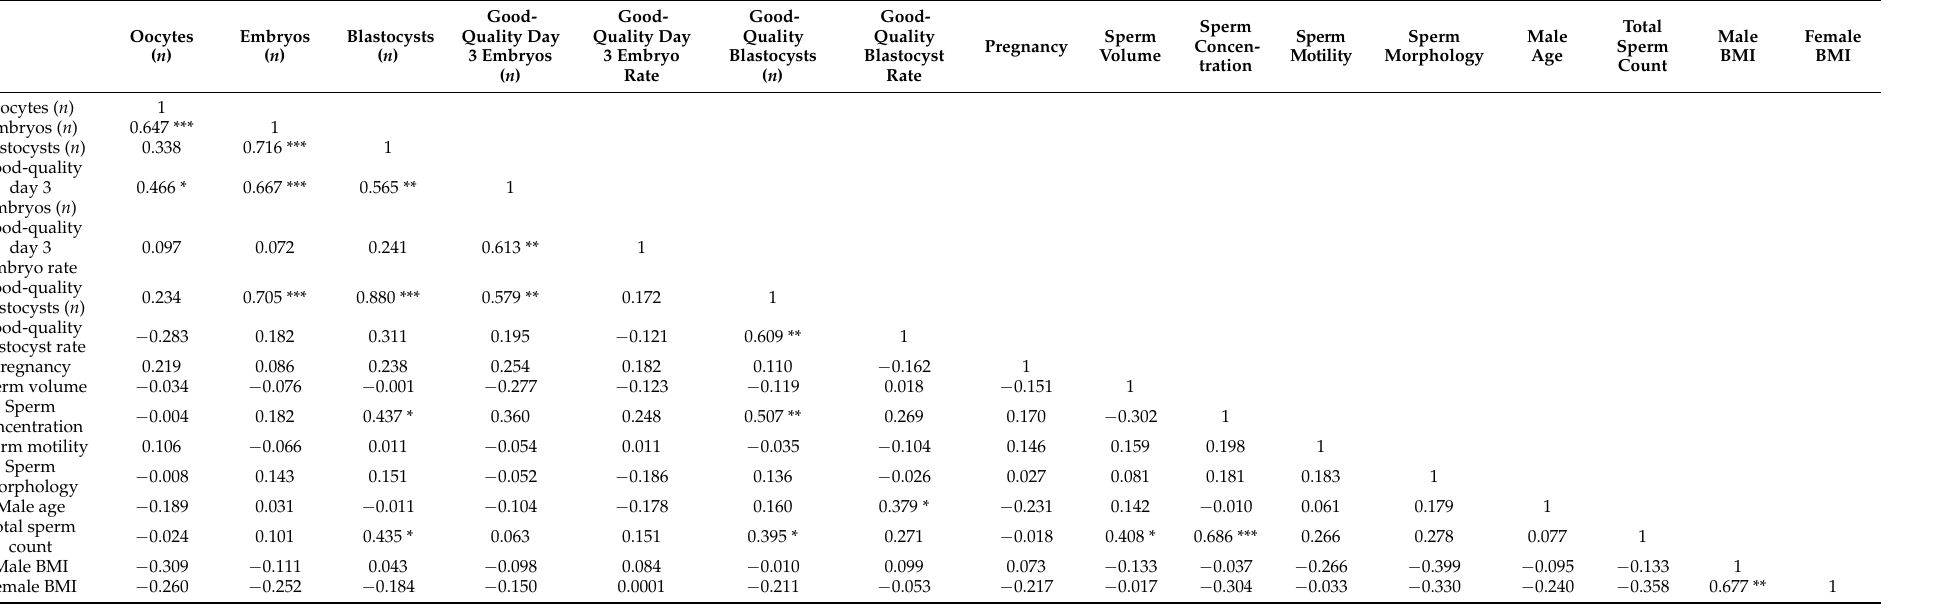
Table 3. Spearman’s correlation matrix of associations between selected variables of the IVF/ICSI cycle outcome and basic parameters of semen